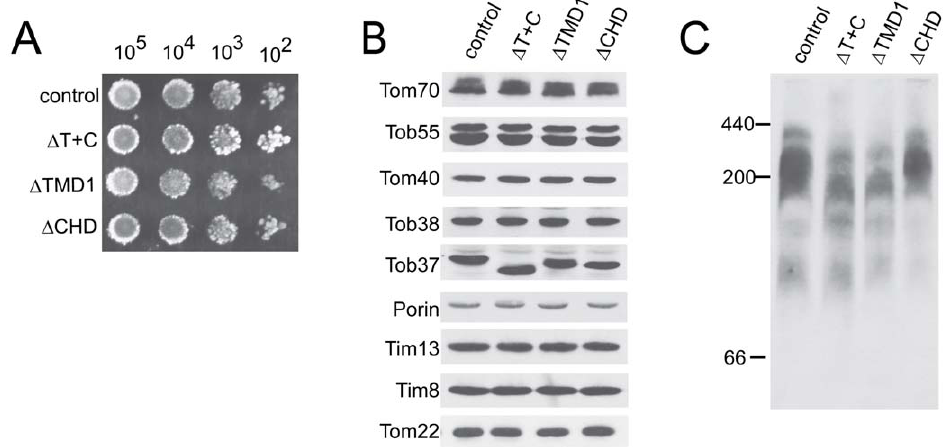
Figure 6. Characteristics of Tob37 C-terminal deletion strains. (a) Conidia from the strains indicated on the left were plated as described in the legend to Figure 1B. (b) Mitochondria were isolated from the strains indicated at the top of the panel and analyzed as described in the legend to Figure 1C. The control was strain 76–26. (c) Mitochondria isolated from the strains indicated at the top of the panel were dissolved in 1% digitonin, subjected to BNGE, transferred to PVDF, and decorated with antibody to Tob55. The position of molecular weight markers is indicated on the left.